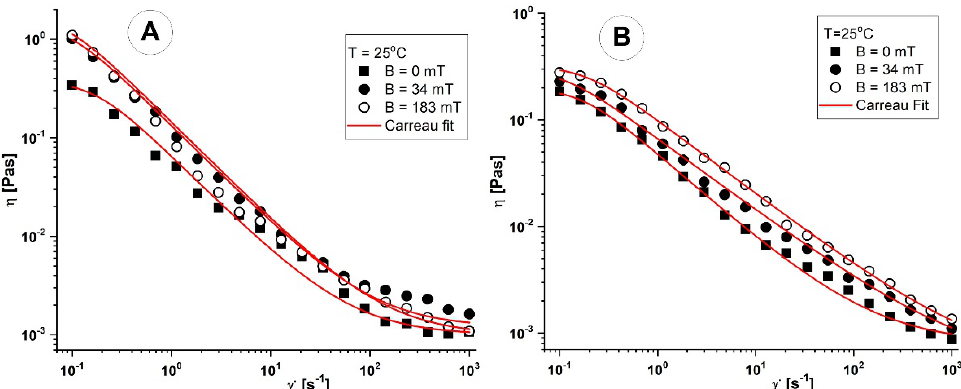
Figure 12. Viscosity curves in the absence and presence of the magnetic field for investigated IONPs. ( A ) Spherical shape MNPs. ( B ) Cubic shape MNPs.